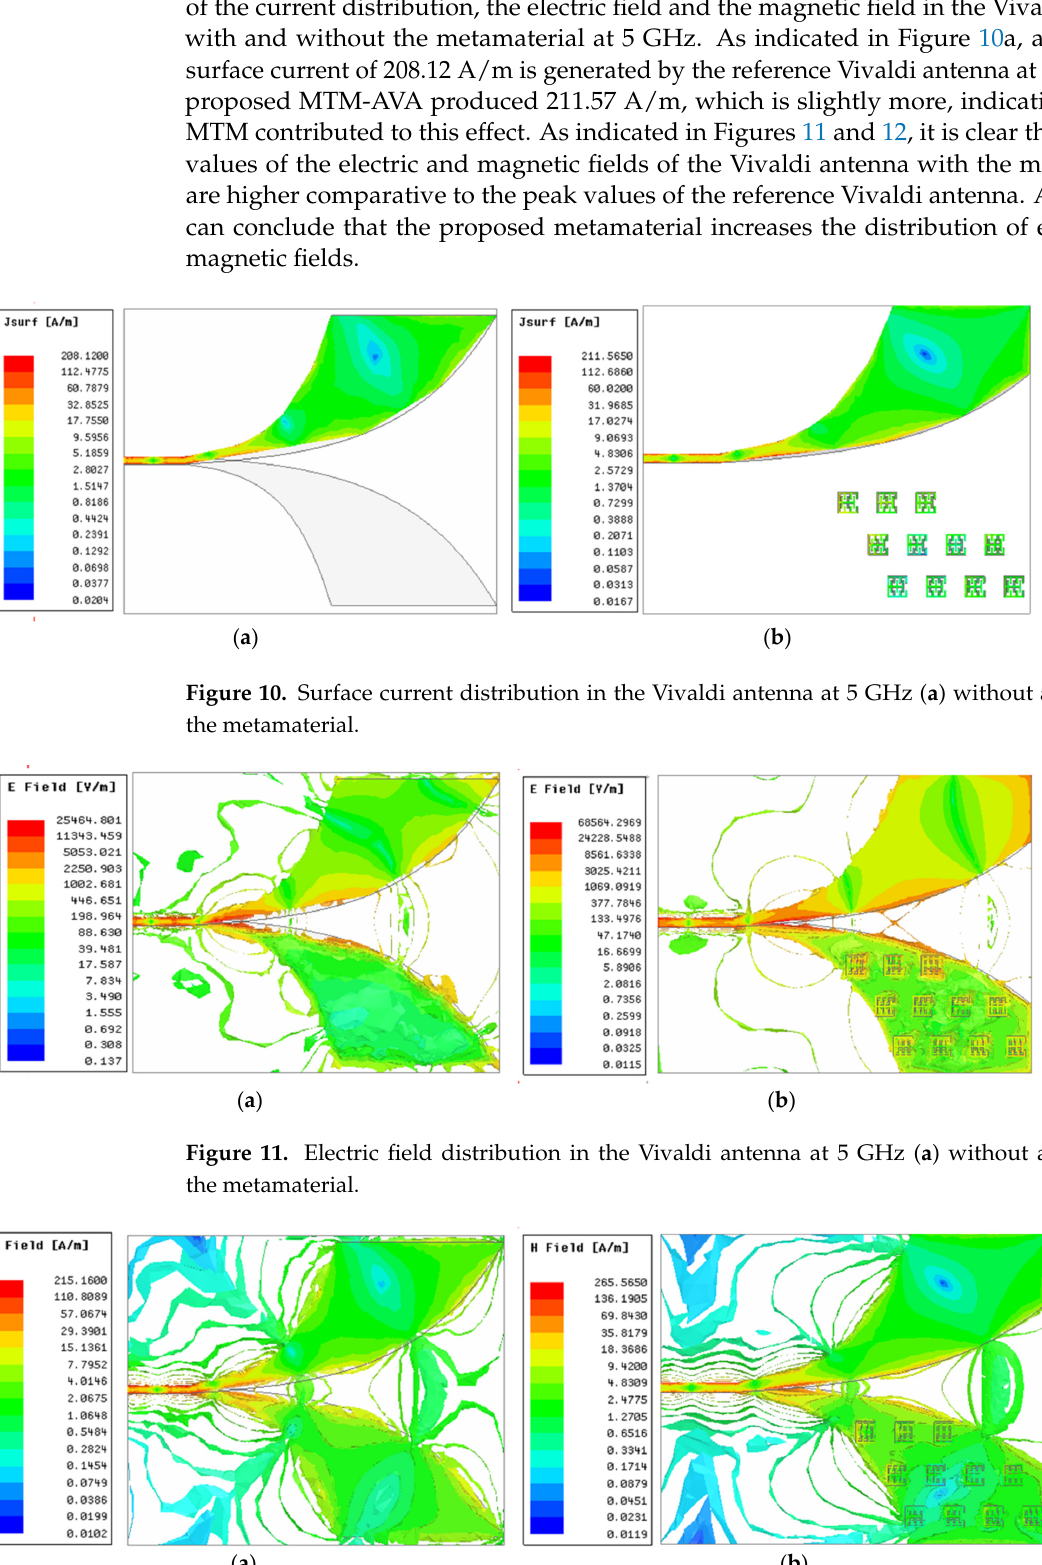
Figure 9. Comparative study of S parameter results of the AVA with and without the metamate- rial.